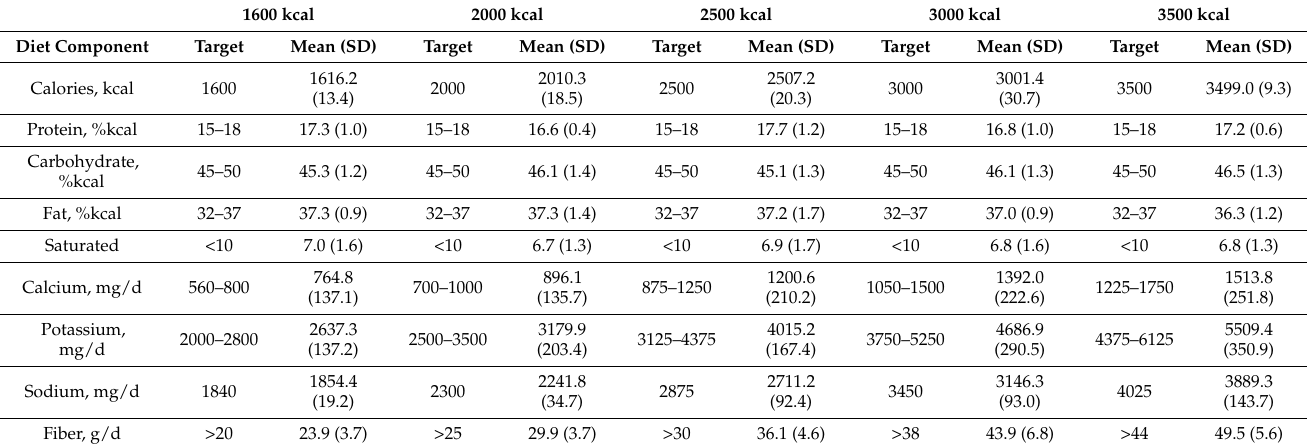
Table 1. Nutrient Targets by Calorie